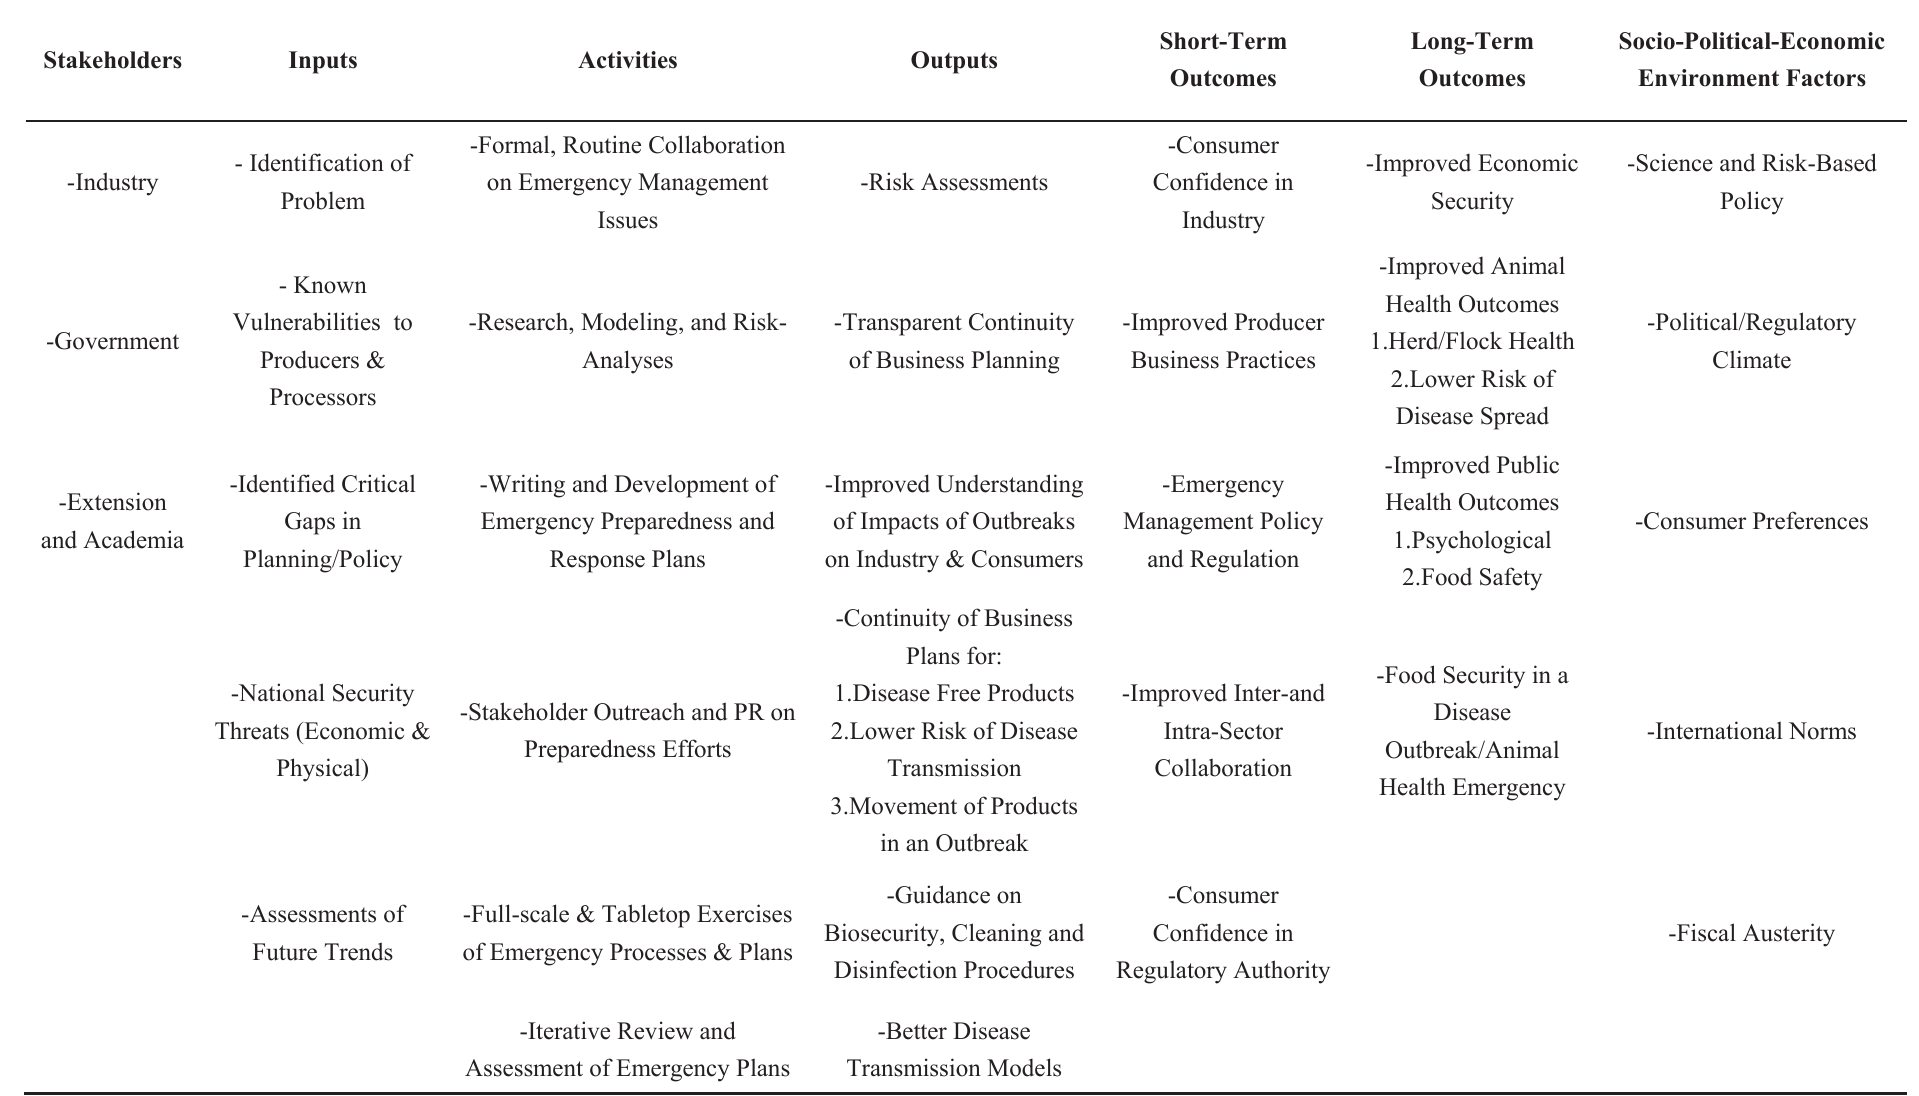
Table 1. Logic model components and factors for continuity of business for foreign animal disease